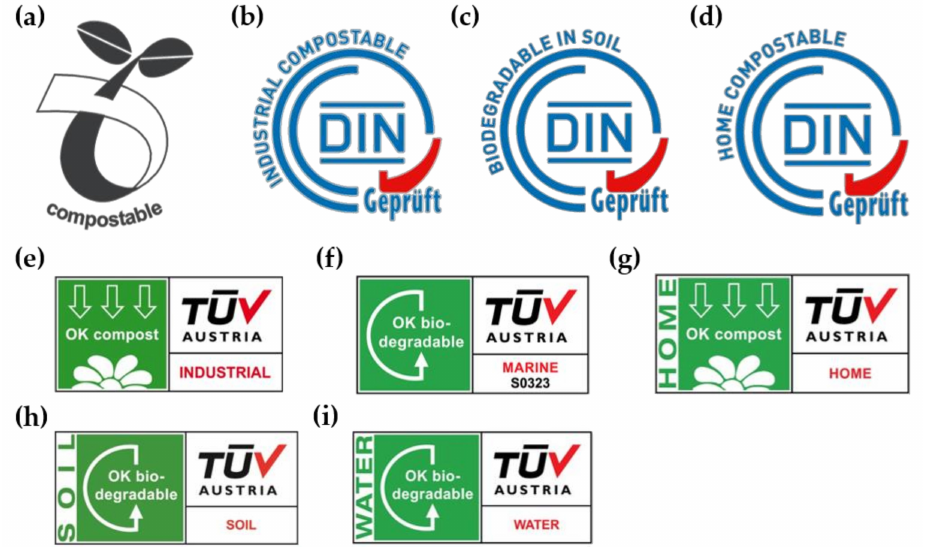
Figure 1. Certification labels relating to biodegradability and compostability: ( a ) seedling logo by Eu- ropean Bioplastics , indicates that the product is industrially compostable and complies with EN 13432; ( b – d ) DIN CERTCO labels for industrial compostability, biodegradability in soil and home composta- bility, respectively; ( e – i ) TÜV Austria labels for industrial compostability, marine biodegradability, home compostability, soil biodegradability and freshwater biodegradability,